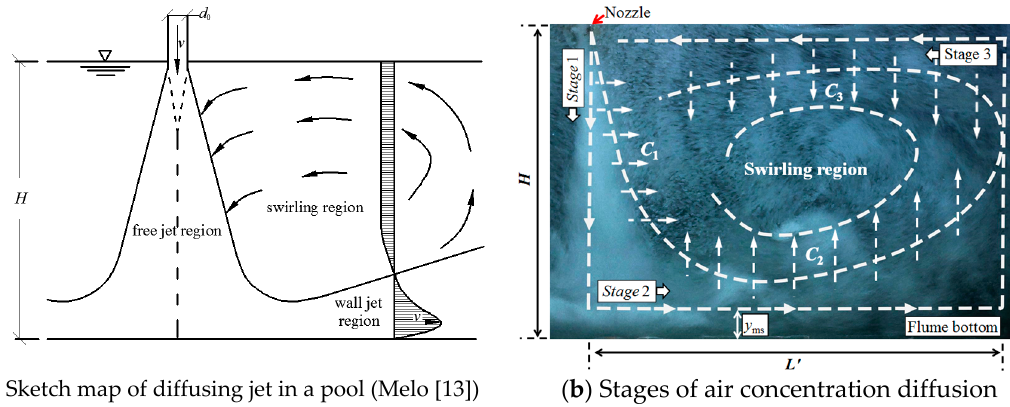
Figure 7. Generalized calculation of air concentration in the swirling region.